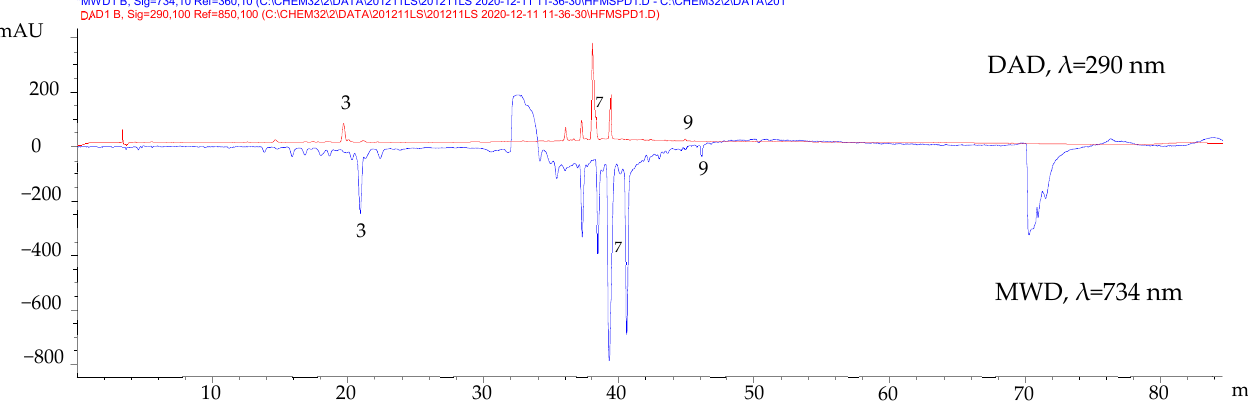
Figure 2. Chromatographic profiles of the fresh leaves MSPD extract before and after derivatization using ABTS reagent.